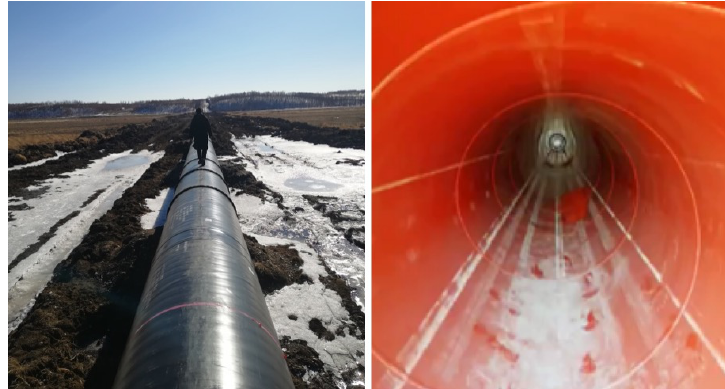
Figure 12. Testing scene at the Heihe Pipeline Construction Site.